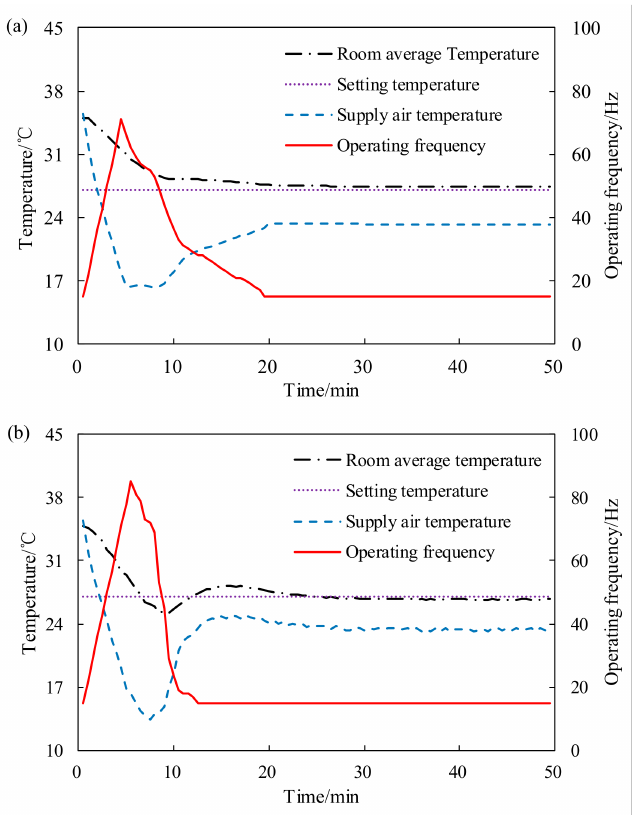
Figure 11. Dynamic variation of room temperature when varying air supply angle: ( a ) 105 ◦ ; ( b ) 75 ◦